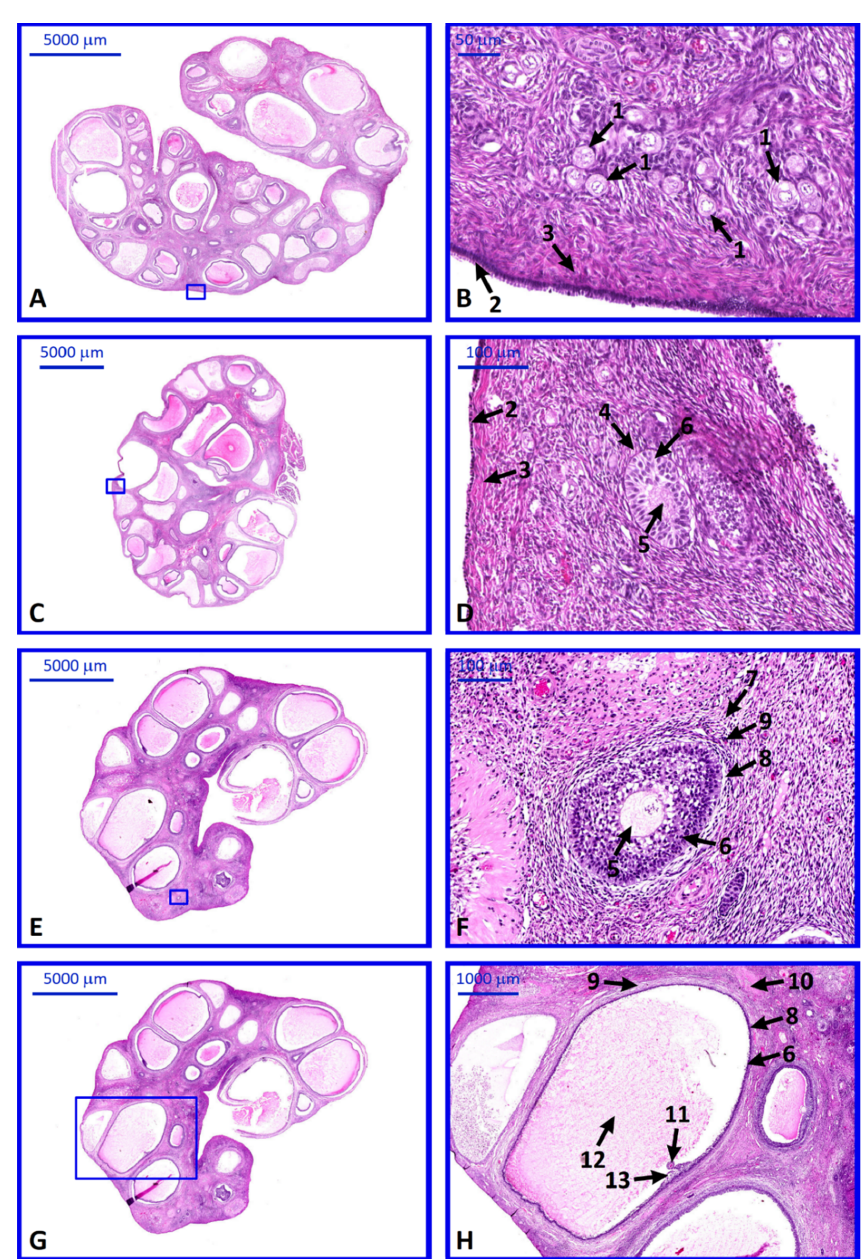
Figure 9. H and E stained ovaries ( A , C , E , G ) with follicles in particular stages of development ( B , D , F , H ). B , D , F , H represent selected areas of A , C , E , G observed in higher magnification (with blue square indicating the magnified region). Arrows: 1—primordial follicles, 2—germinal epithelium, 3—